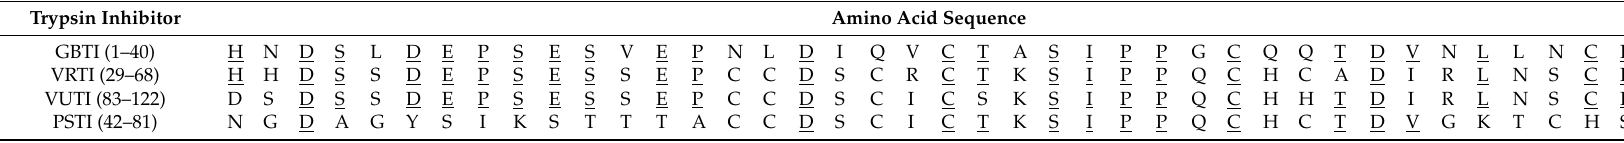
Table 2. N-terminal sequence comparison of gold bean trypsin inhibitor with those from other leguminous species (identical corresponding amino acid residues are